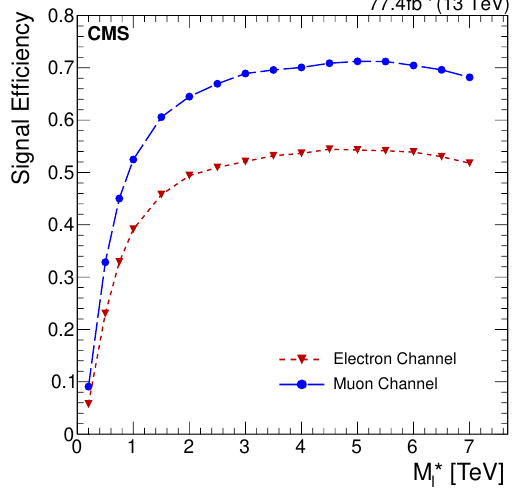
Figure 6 . Signal e(cid:14)ciency after all selections are applied, as a function of the excited lepton mass M , based on simulated ‘ (cid:3)